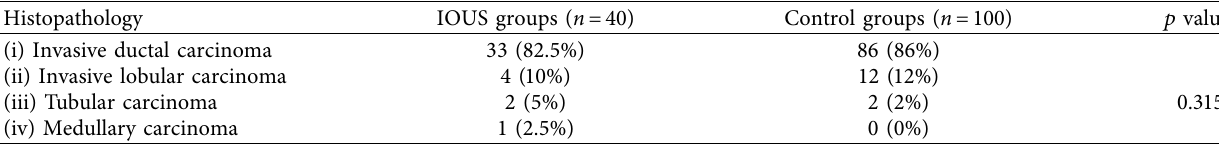
Table 2: Tumor histopathology in the two study groups.